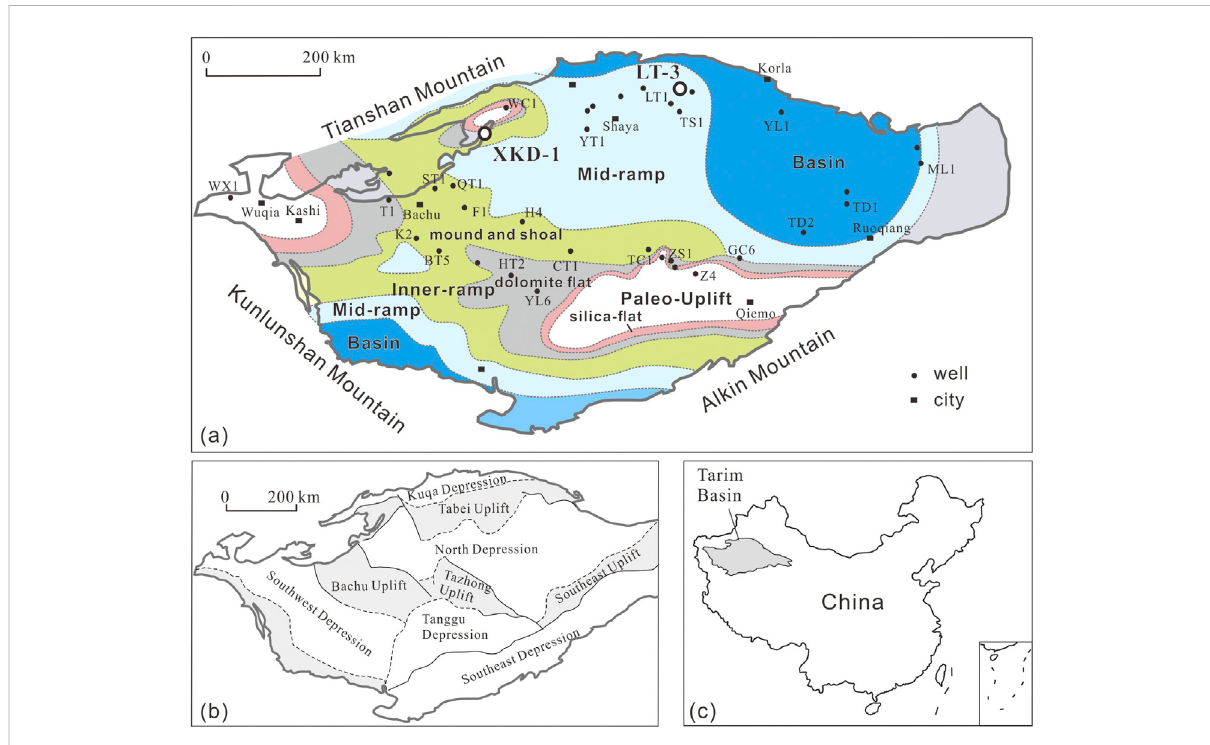
FIGURE 1 Lithography paleography during the deposition of the Xiaoerbulake Formation (modi fi ed from Wei et al., 2021) and the location of well XKD-1. (A) Lithography paleography of the Xiaoerbulake Formation. (B) Tectonic units of the Tarim Basin. (C) The location of the Tarim